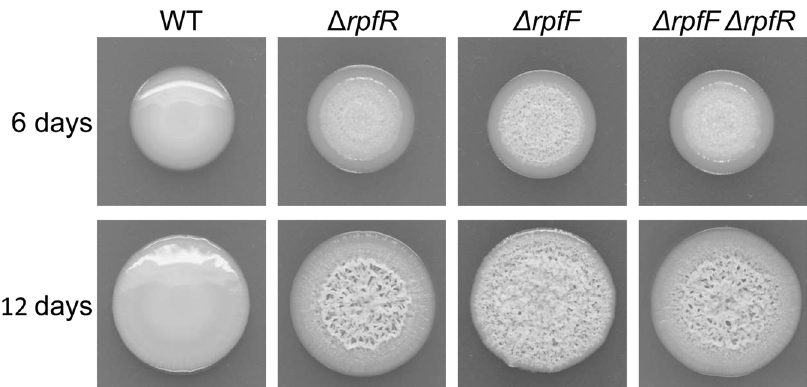
Fig. 1 Colony morphology of B. cenocepacia strains with mutated or intact RpfFR QS system. Cell suspensions of wild-type B. cenocepacia H111 (WT) and mutants carrying an in-frame deletion of rpfF , rpfR , or both genes were spotted on NYG agar plates. Colony morphology was assayed after growth for 6 and 12